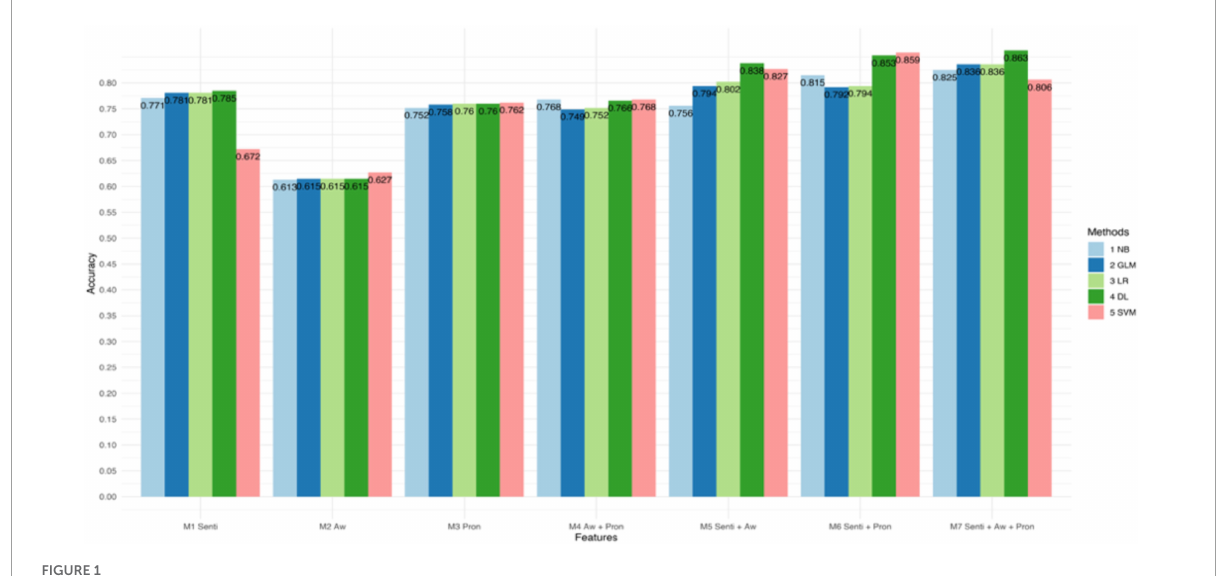
FIGURE1 Accuracy of different models in classifying texts of anxiety.